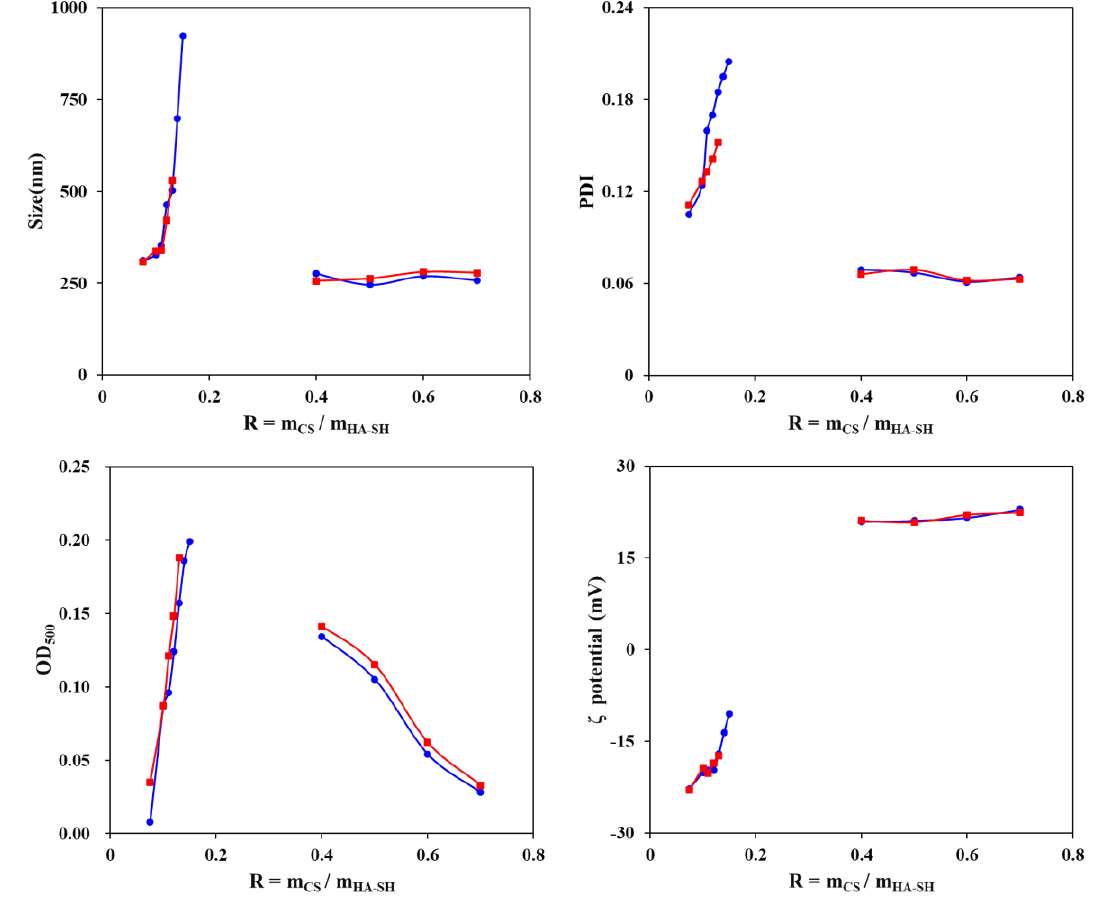
Figure 2. Nanoparticle size, polydispersity index (PDI), optical density at 500 nm (OD 500 ), and ζ Figure 6. Storage stability (Particle size, PDI, OD 500 ) of the HA – SH/CH nanoparticles at pH = 4.5 potential of HA – SH/CS nanoparticles as a function of the mass ratio of CS and HA – SH before oxi- after oxidation. R = 0.10 ( ) and R = 0.50 ( dation ( ) and after oxidation ( ). ) and after oxidation (